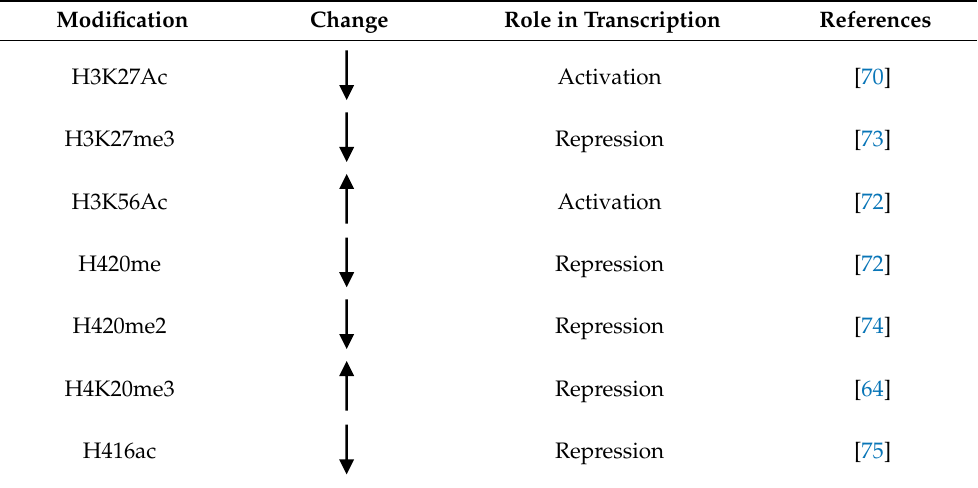
Table 1. Histone modification patterns in association with aging.